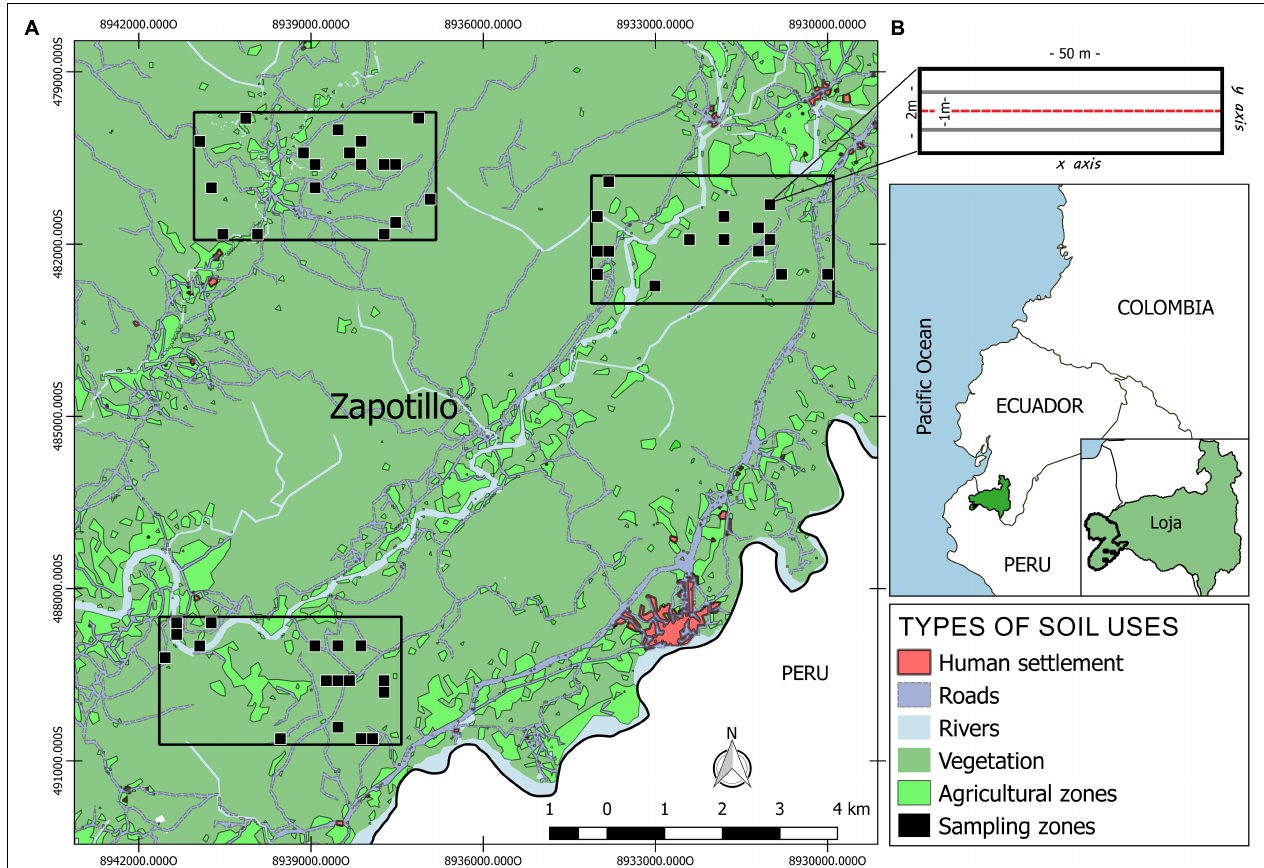
FIGURE 2 | Location of the study site. (A) Location of the established grids, black dots represent the location of sampling cells randomly selected. (B) Transect design, where the black edge represents the area of tree sampling, and the central gray border area that of shrubs